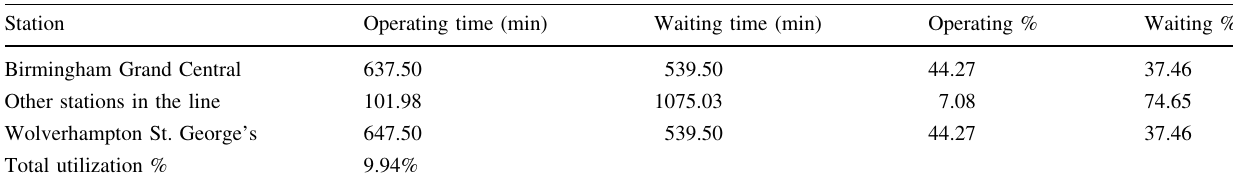
Table 8 Total utilization of the metro line in clockwise direction Station